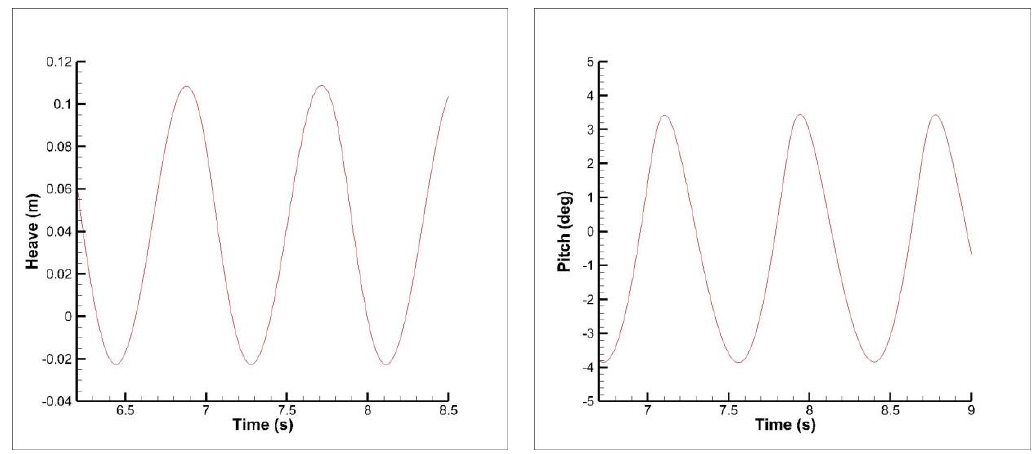
Figure 17. Bow accelerations for mono ( left ) and warped ( right ) hulls at Fn B = 2.82.